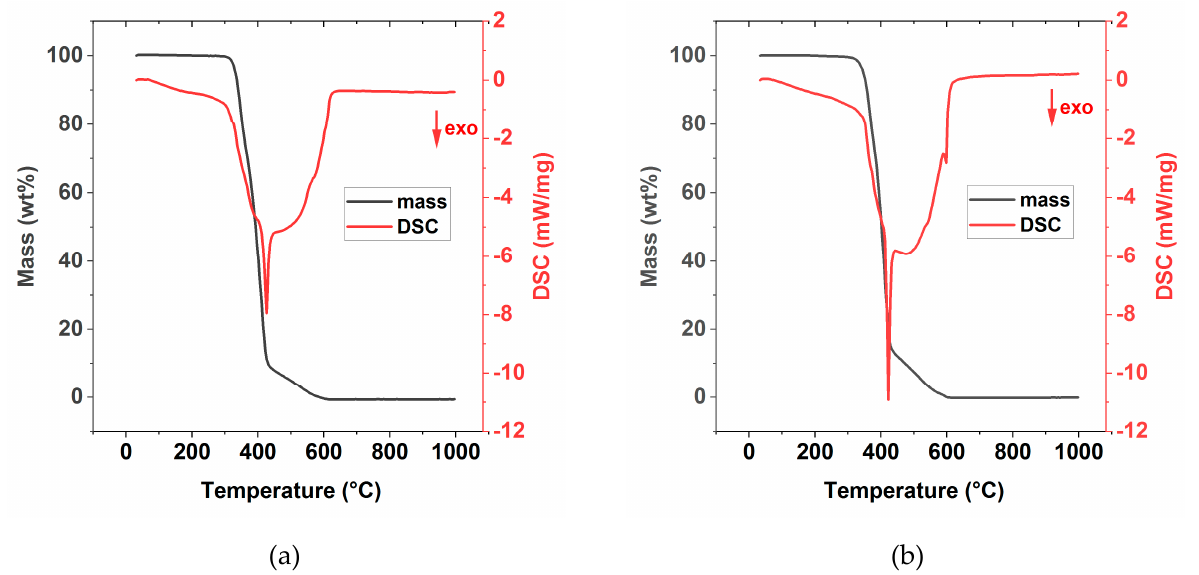
Figure 5. Graphical representation of the results of the TGA-DSC analysis of ( a ) P[C 2 N MA,22 ]TFSI; ( b ) P[C 2 N A,22 ]TFSI.